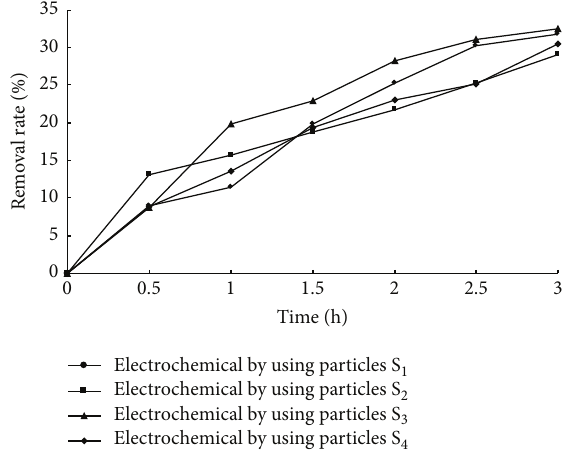
Figure 5: Degradation of MB solution with three-dimensional